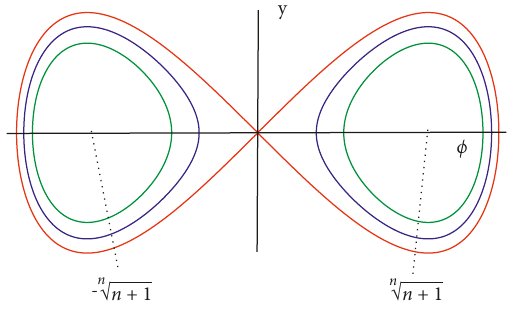
Figure 2: The phase portrait of equation (11)